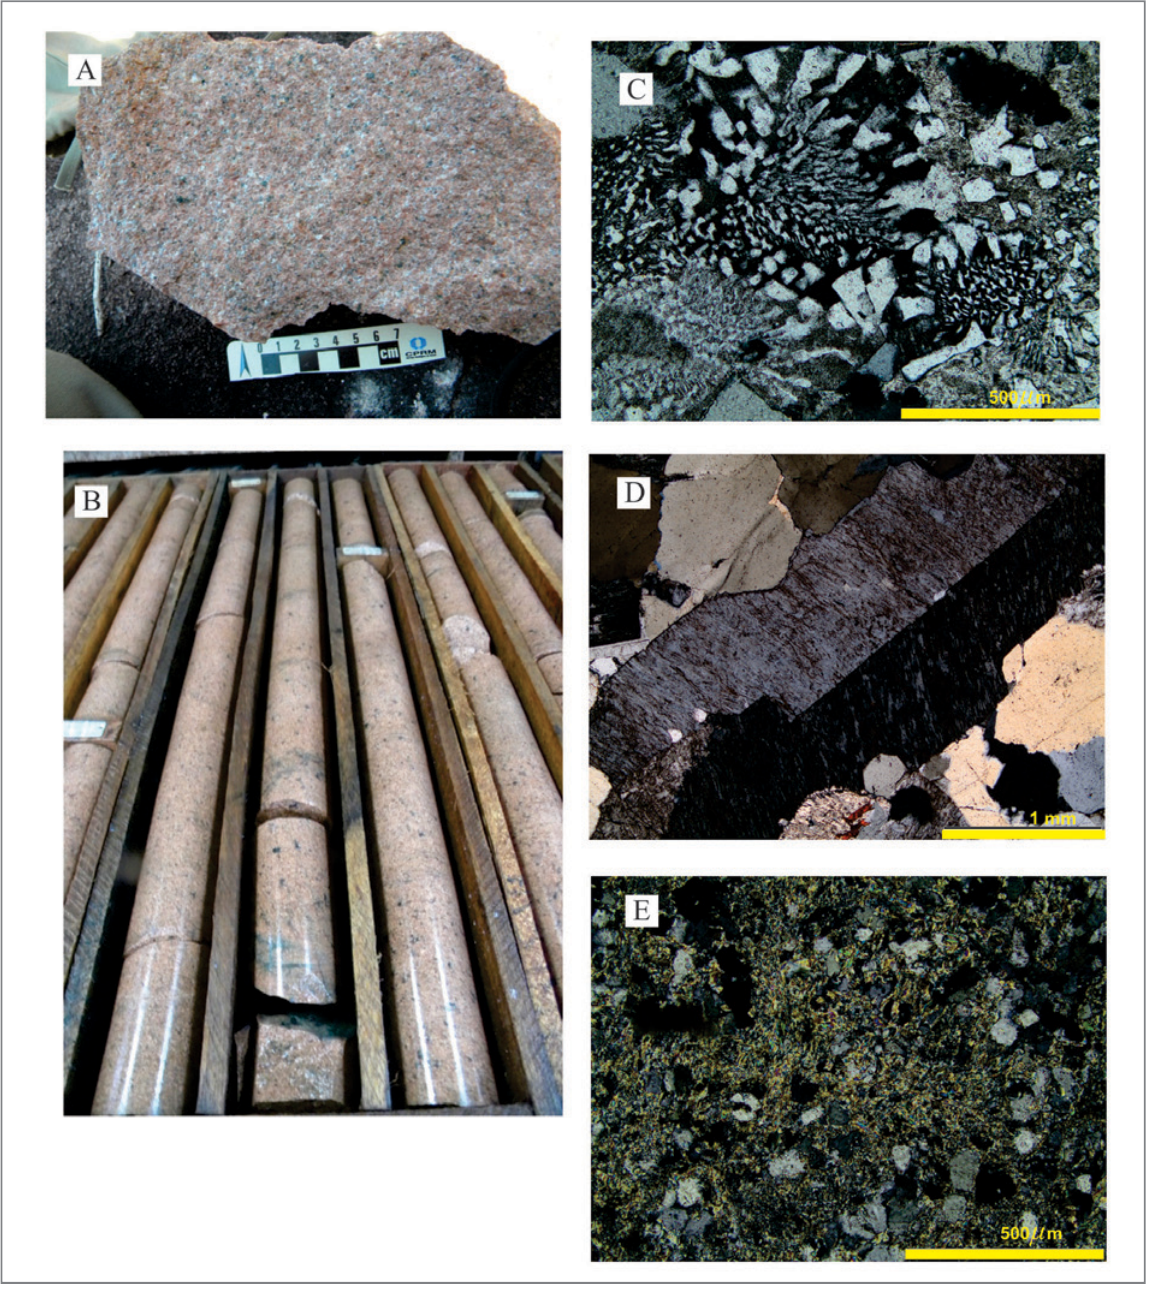
Figure 10 - Aspects of the Serra Alkali Feldspar Granite. A) Fine-grained equigranular pinkish granite; B) drill holes from the Coringa deposit with the same granite of “A”; C) granophyric texture; D) twinned potassium feldspar crystal; E) sericitization of potassium feldspar.